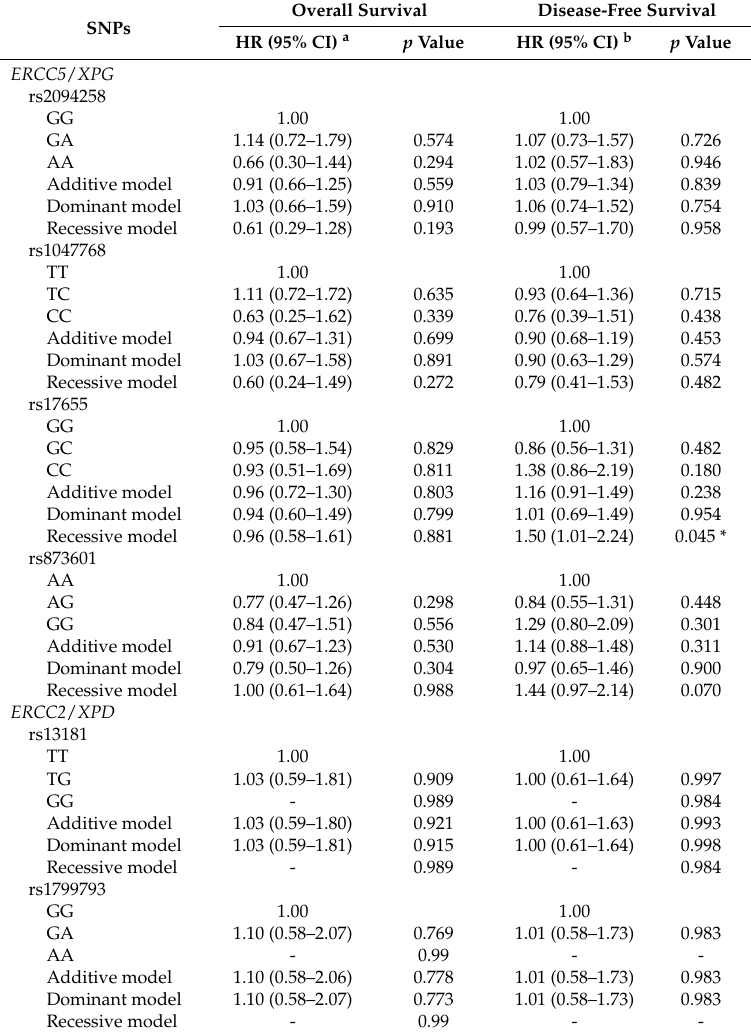
Table 3. Multivariate association between nucleotide excision repair (NER) candidate single nucleotide polymorphisms (SNPs) and OSCC survival in patients treated with CCRT. Overall SNPs